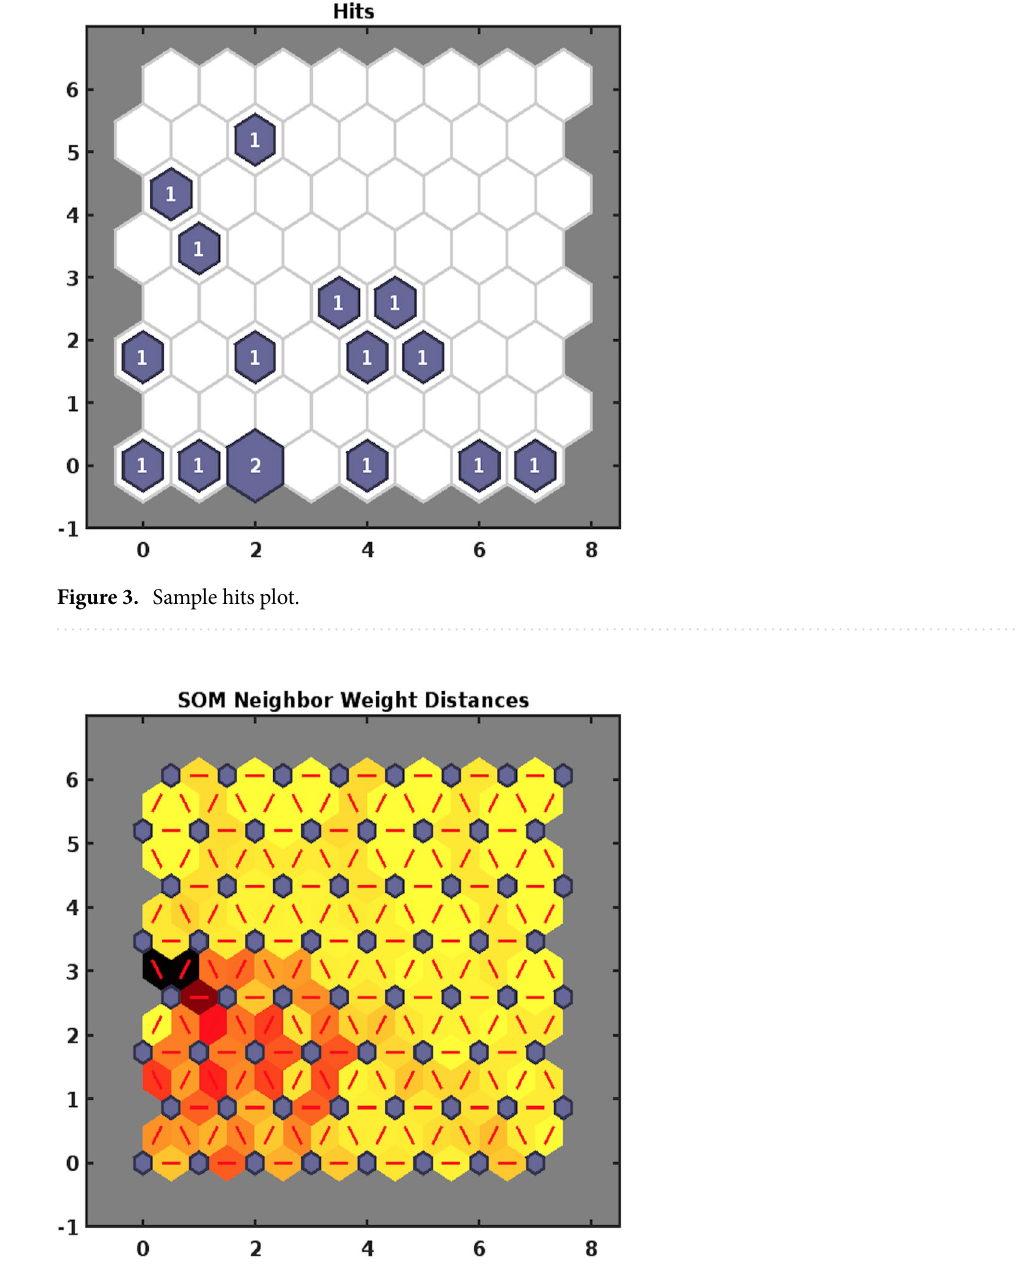
Figure 4. Weight distances